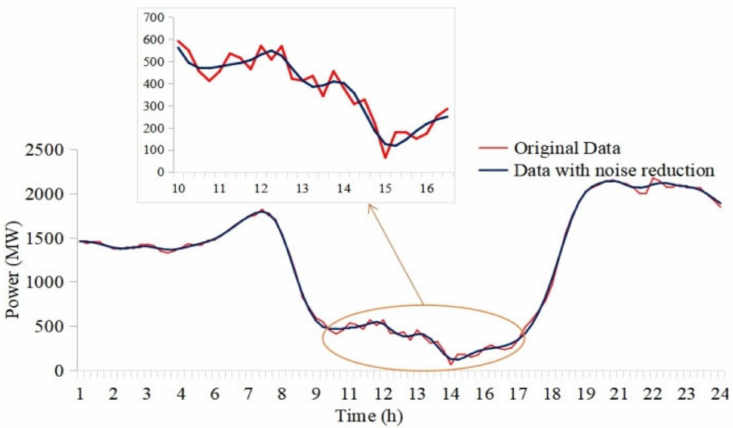
Figure 4. Comparison diagram of the net load with noise reduction and the original